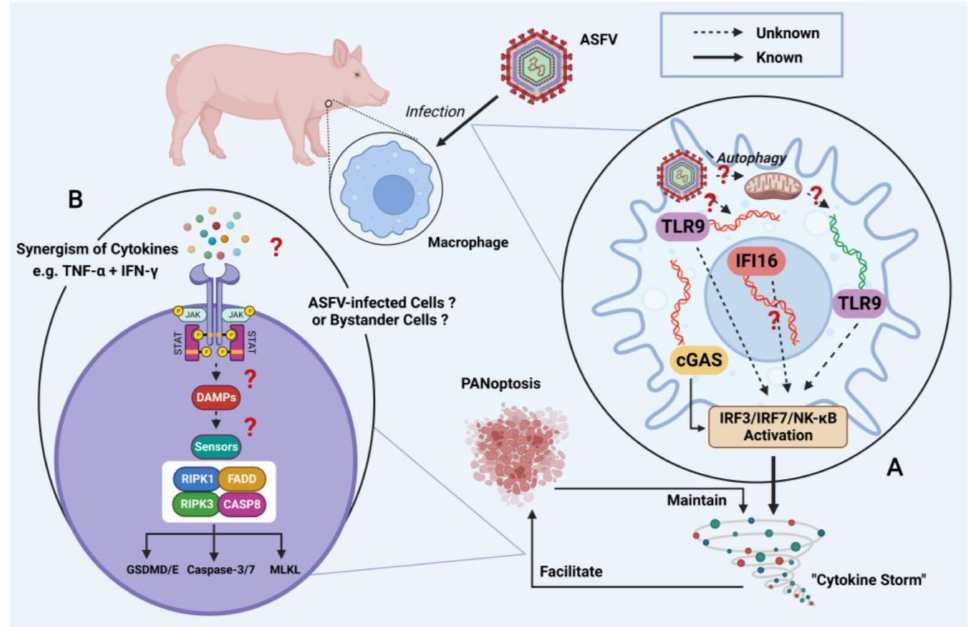
Figure 3. Schematic overview of scientific hypotheses proposed in this review. ( A ) Other nucleic acid sensors may be involved in ASFV detection. Mechanistically, TLR9 may directly recognize the unmethylated CpG DNA in the ASFV genome somehow or by indirectly sensing the ASFV-induced mitophagy-mediated mtDNA release. IFI16 may recognize ASFV through binding to viral DNA or sensing ASFV-induced host DNA damage. ( B ) Synergism of multiple cytokines may facilitate the PANoptosis; in turn, PANoptosis may sustain the ASFV-induced cytokine storm